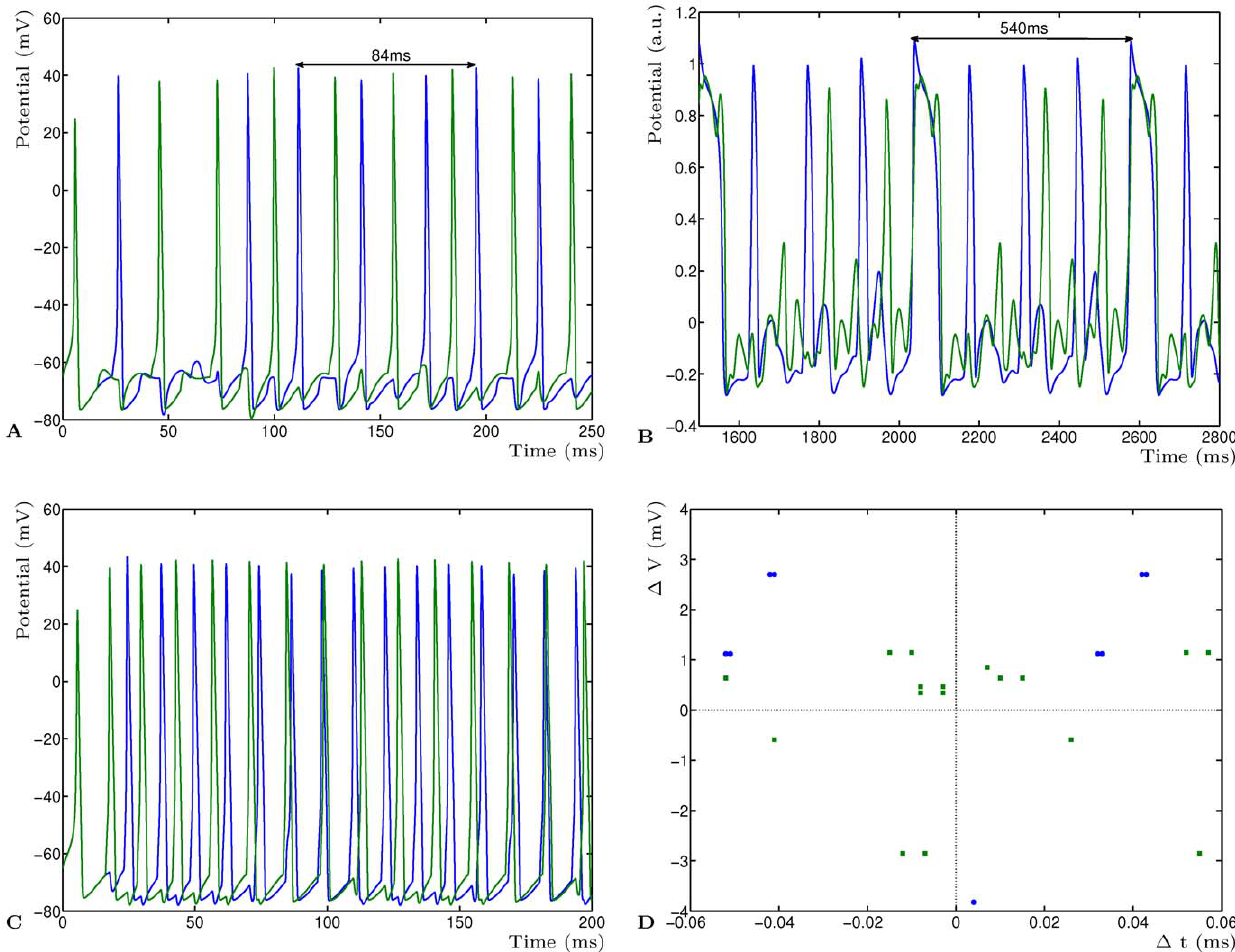
Figure 3. The adaptation of the neural activity by the STD model is independent from the membrane conductance model. A Activity of two neurons X 2 and X 3 showing the LCM at the fundamental frequency of 11.9 Hz (84 ms) for a network constructed using the Hodgkin-Huxley conductance model. B Activity of neurons X 2 and X 3 showing the fundamental frequency of 1.85 Hz, using the Fitzhugh-Nagumo model. C The network of HH neurons and synaptic transmission as in panel lbfa, but without adaptation. The neurons function as simple coincidence detectors and do not converge to the LCM. Due to the difference in periodicity of the two neurons they will eventually go completely out of phase. D Phase diagram of the relative change in membrane voltage for the HH network versus the relative change in timing induced by deterministic LTD adaptation. Shown are the stable phase differences for neurons X 2 (blue) and X 3 (green) for at least 20 periods. The phase difference was calculated by determining the timing differences of spiking events for individual periods between synapses connecting X 2 and X 3 of the adapted network and the non-adapted network. The corresponding difference in amplitude of the membrane activity for each event provides the relative change.